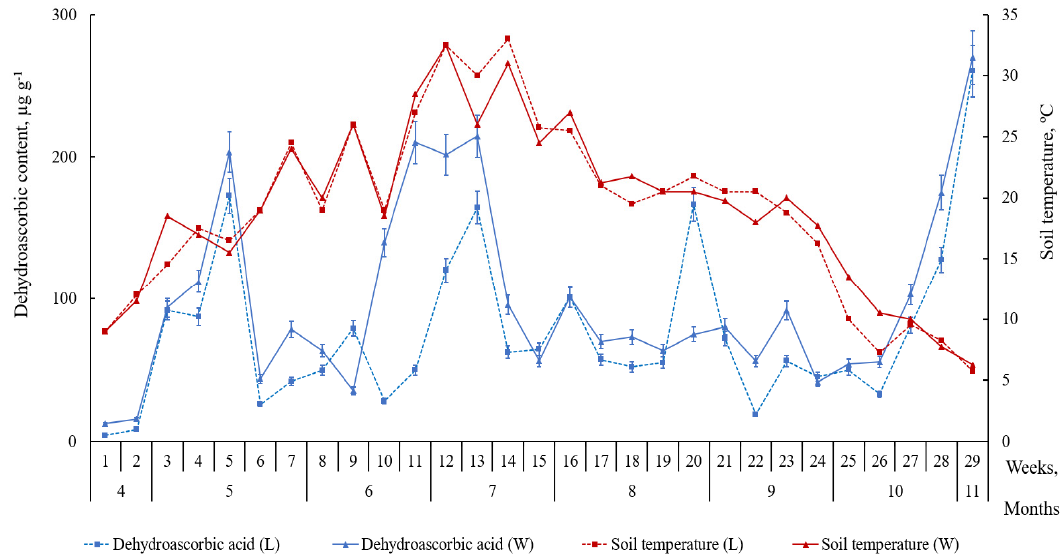
Figure 5. The content of dehydroascorbic acid (DAA) in the leaves of Lathyrus maritimus ( μ g g − 1 DW) and the temperature conditions of the leeward (L) and windward (W) sides of the foredune (April–November 2018). Data expressed as mean values ± standard deviations, ( n = 45). Differences considered significant at p ≤ 0.05. (below 13 °C) and stronger winds caused an increase in both the formation and consumption of ascorbic (DAA and DKGA) (Figure 5, Figure 6).